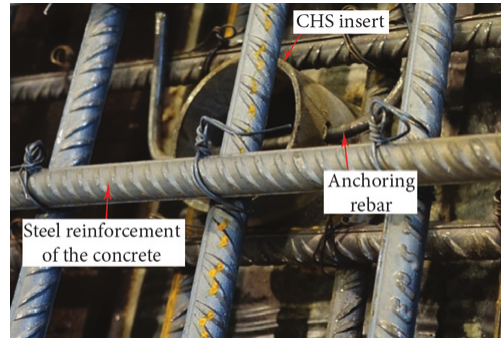
Fig. 4. Sample prepared for concrete casting